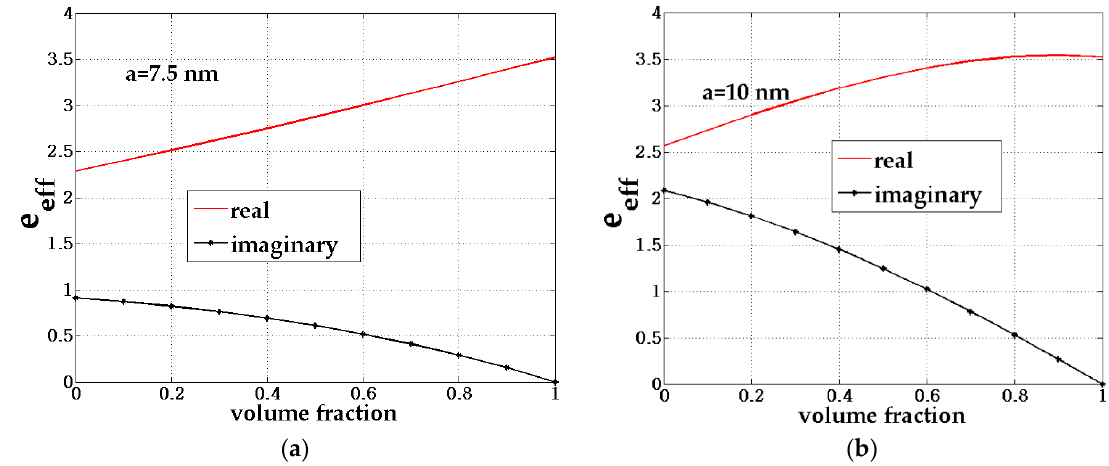
Figure 10 . The composite effective permittivity with variations in the volume fraction ( F ) of the composite for the fixed size of the core-shell of ( a ) 7.5 nm and ( b ) 10 nm.